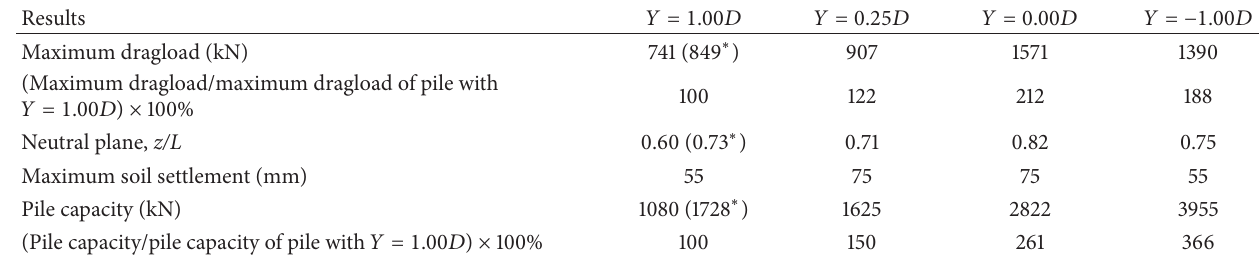
Table 3: Summary of the computed